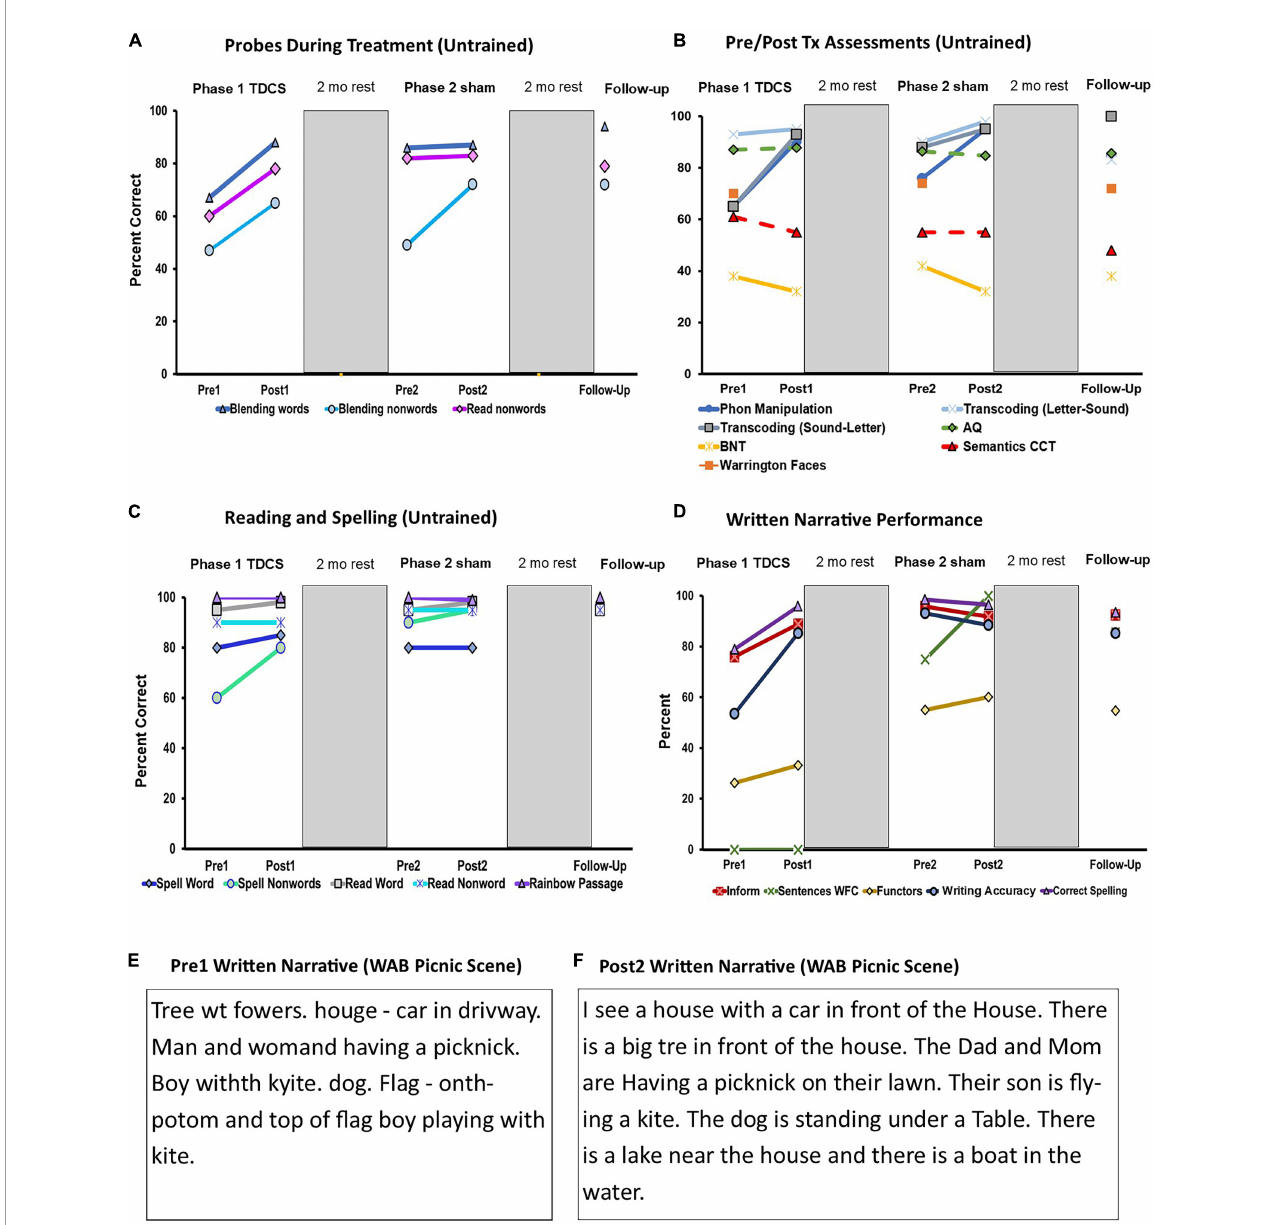
FIGURE2 (A) Multiple baseline probes: Performance before and after treatment Phase 1 (active tDCS), Phase 2 (sham tDCS), and at follow-Up; (B) Pre/Post Tx assessment measures: Performance before and after treatment Phase 1 (active tDCS), Phase 2 (sham tDCS), and at follow-up for, AQ, aphasia quotient; BNT, boston naming test; CCT, Camel and Cactus Test; (C) Measures of reading and spelling: Performance before and after treatment Phase 1 (active tDCS), Phase 2 (sham tDCS), and at follow-up; (D) WAB written picture description: Performance before and after treatment Phase 1 (active tDCS),